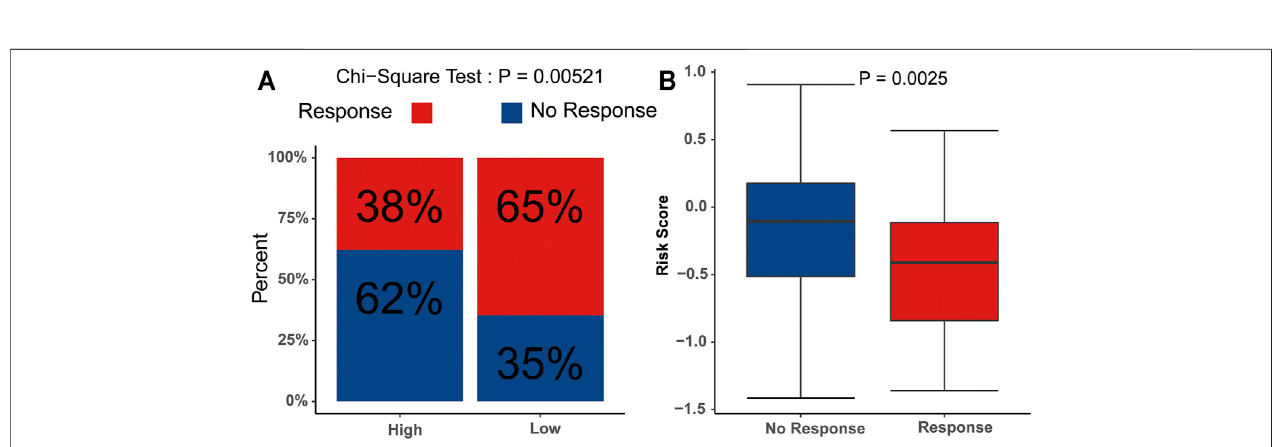
FIGURE 9 | Potential relevance of the signature in immunotherapy response (A) Distribution of the immunotherapy responders in the low- and high-risk group. (B) Evaluation of the differences in risk scores between response group and non-response group.